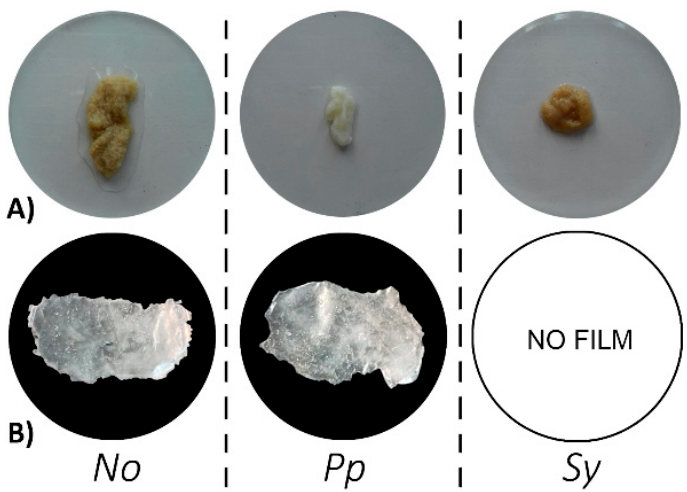
Figure 2. Precipitates ( A ) and biofilms from formulation I* ( B ). No: Nostoc sp.; Pp: Porphyridium purpureum ; Sy: Synechocystis sp. * Conditions: fresh polymer precipitate dissolved in 5% NaCl, and were mixed with glycerol as a plasticizer and dried at 25 °C for 24 h.